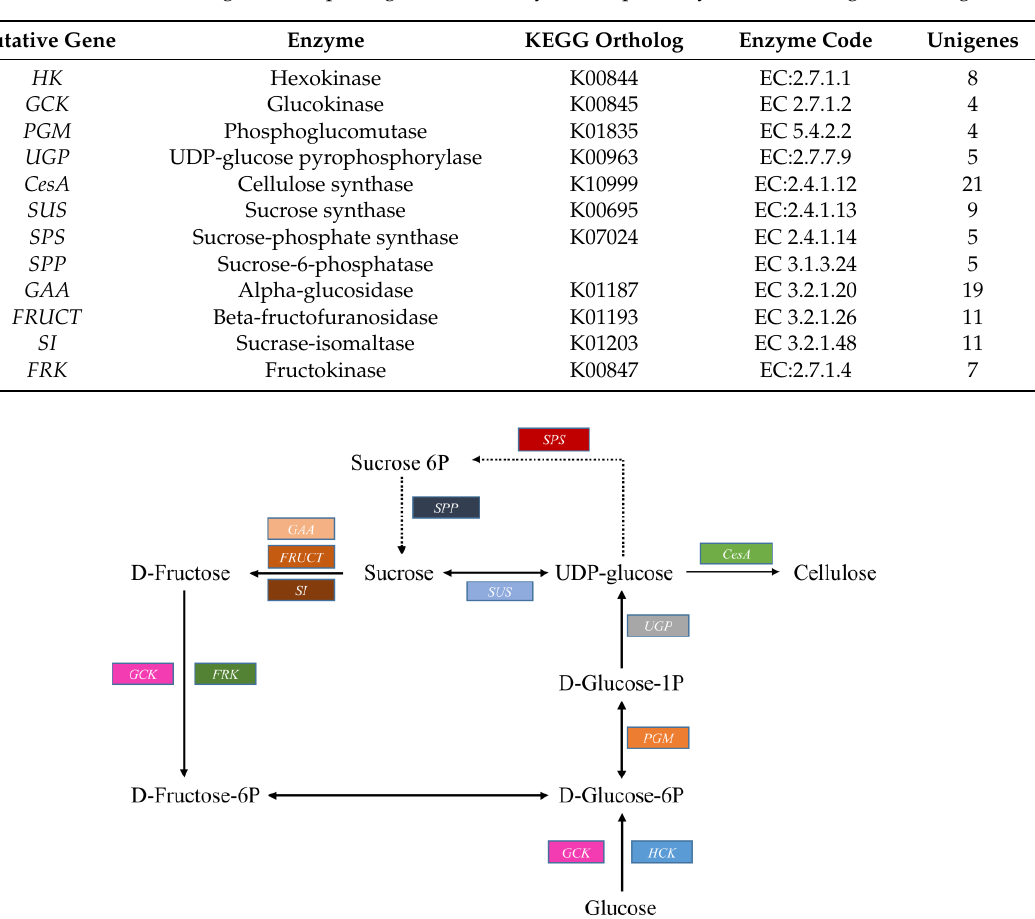
Table 2. List of candidate genes comprising cellulose biosynthesis pathways found among kenaf unigenes.